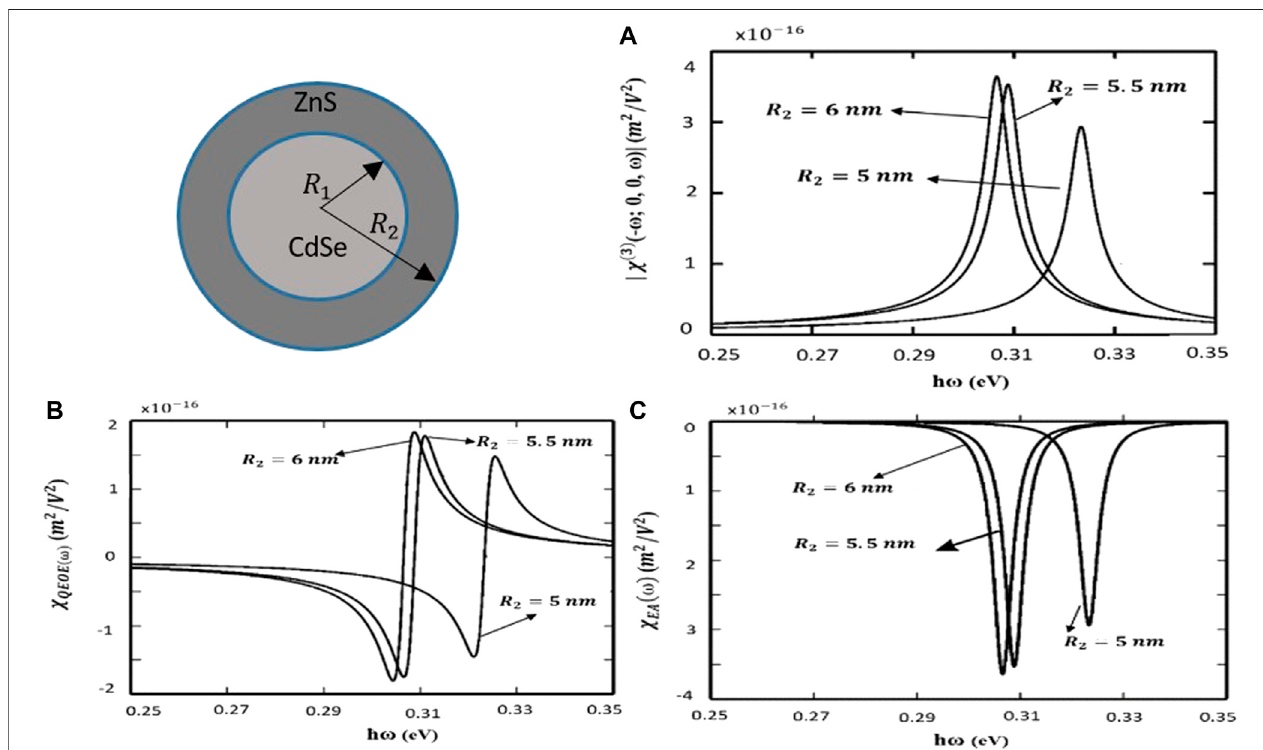
FIGURE 8 | Core-shell quantum dot pictorial diagram representing that the core is made up of CdSe quantum dot of radius R havingaradius R 2 .Third-ordernonlinearityofCdSe/ZnScore-shellquantumdotswithdifferent R 2 and fi xed R 1 (cid:1) 4 . 5 nmweredisplayed above. Themodulusof (A) real part (B) imaginary part (C) χ ( 3 ) (− ω ; 0 , 0 , ω ) versus pump photon are represented in the above fi gures [108].